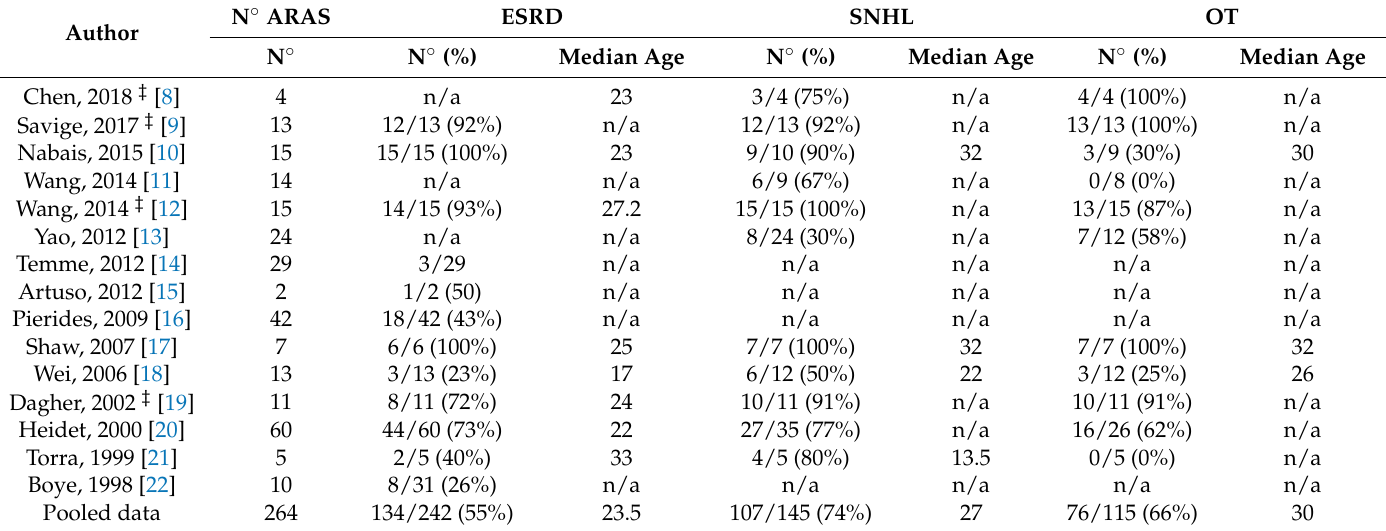
Table 5. Analysis of studies available for aggregate patient